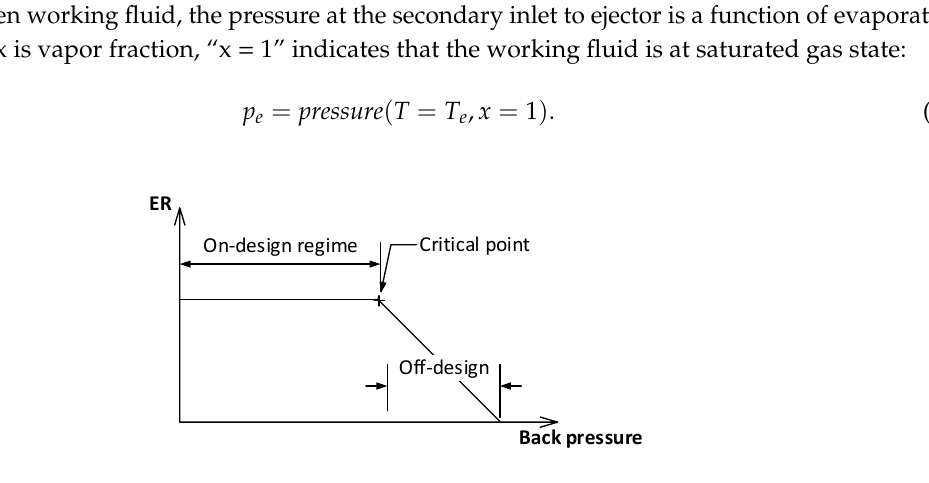
Figure 4. Illustration of various working regimes of an ejector.